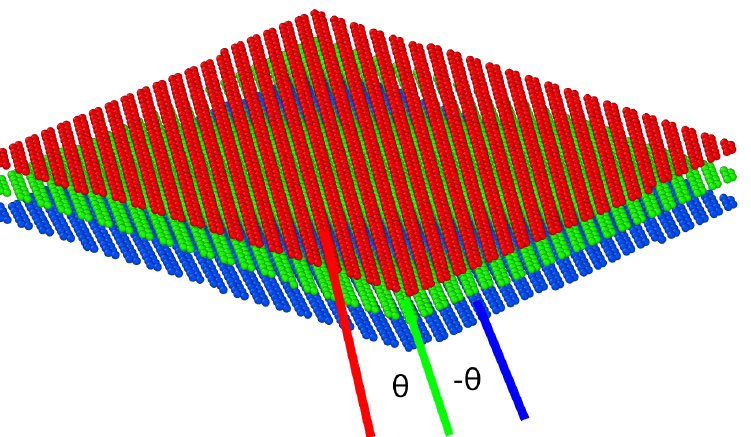
Figure 1. A schematic plot of the twisted tri-layer graphene (tTLG) structure with a twist angle θ